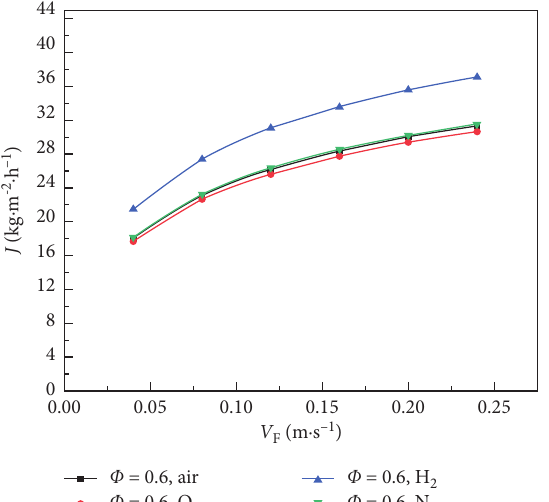
Figure 12: Permeate flux under different inlet velocity of feed side. T W NaCl � 3.5%.